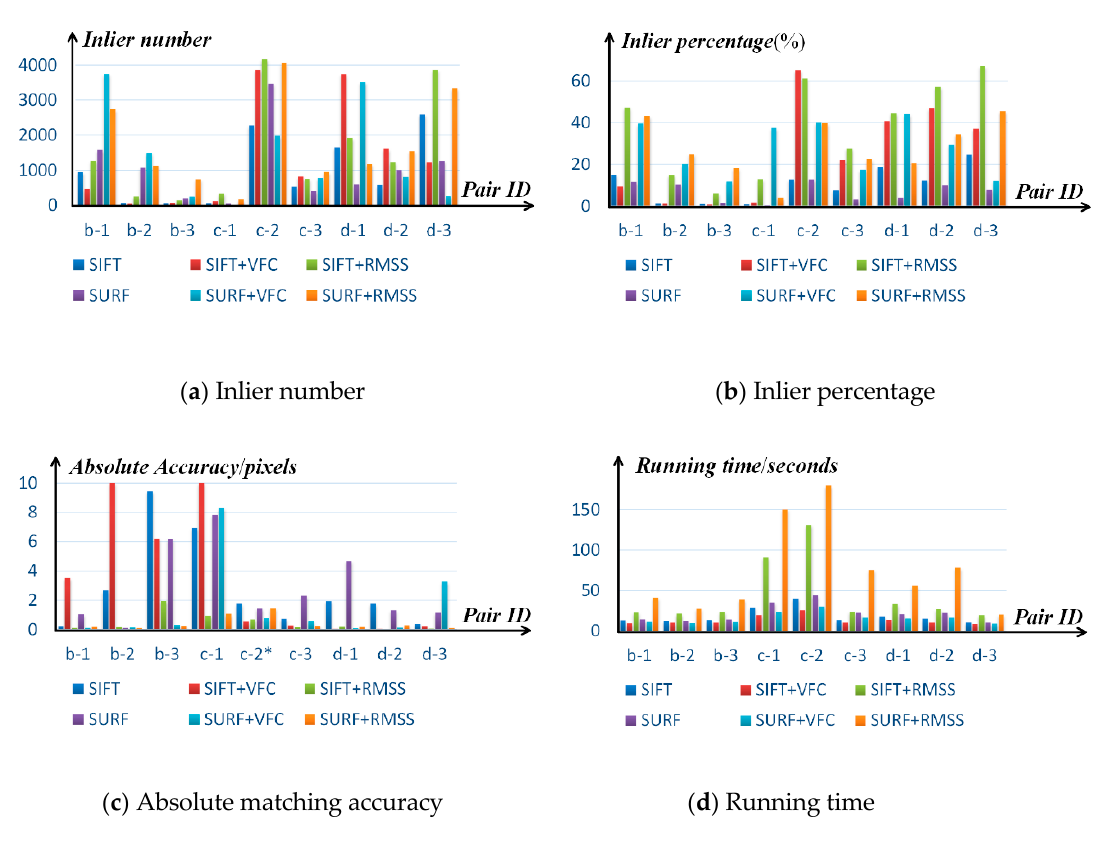
Figure 8. Experimental comparisons among SIFT, SURF, VFC, and the proposed method